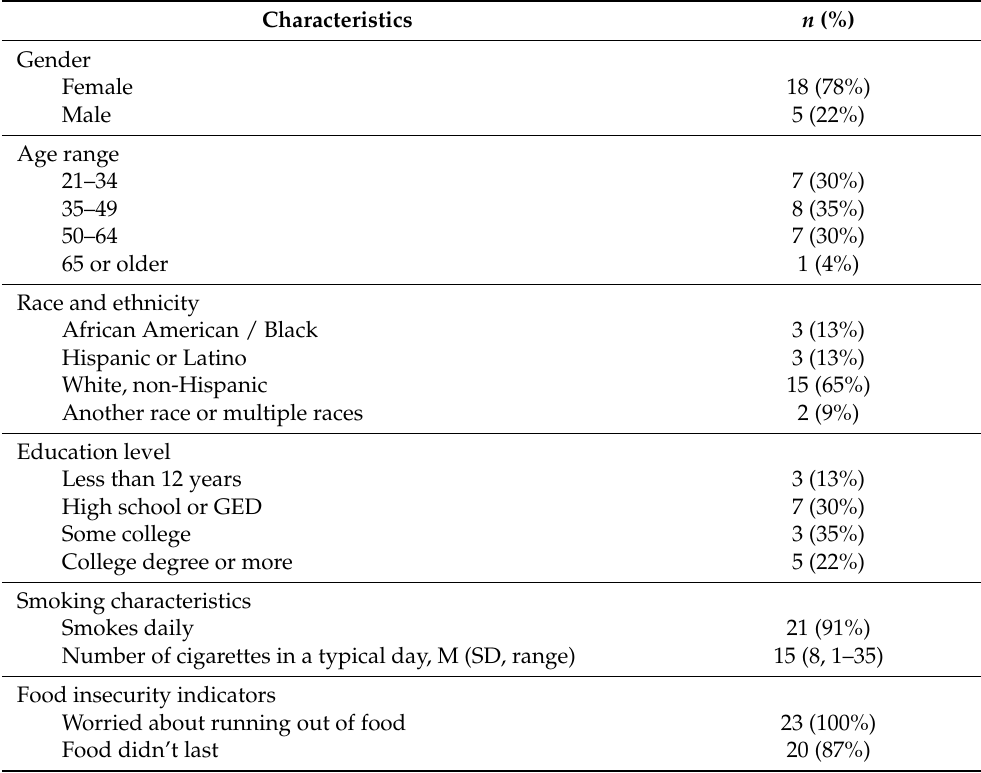
Table 2. Characteristics of Study